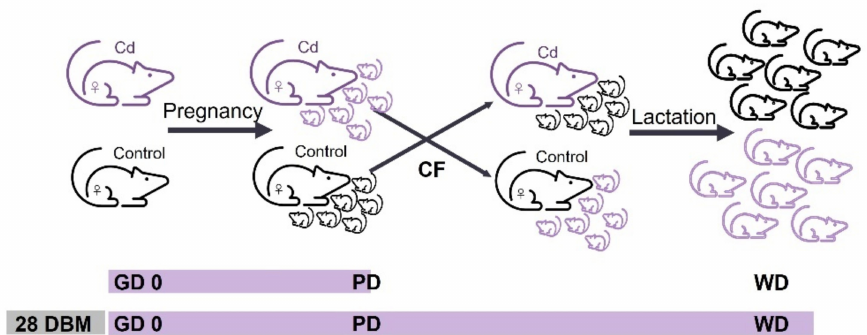
Figure 3. Cross-fostering strategy. Litters of dams exposed to Cd were exchanged at birth with those of the unexposed groups, enabling surrogate parenting. Cross-fostering (CF) was reported for the pregnancy Cd exposure scheme, from gestation day zero (GD 0) to parturition day, and for the pregnancy–lactation scheme from 28 days before mating (DBM) or GD 0 to the weaning day